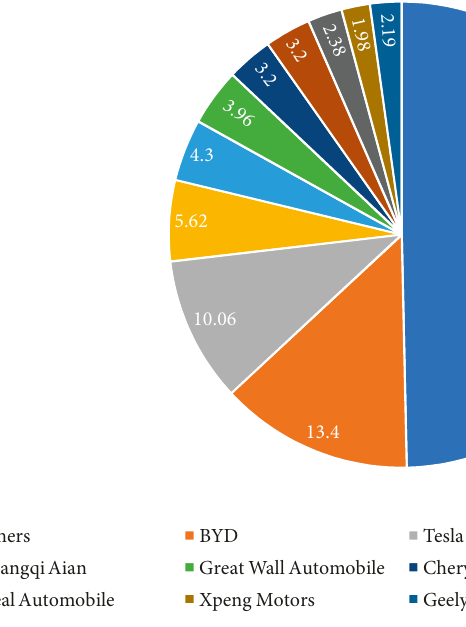
Figure 2: Market share of China’s new energy vehicle industry in 2020 (by sales